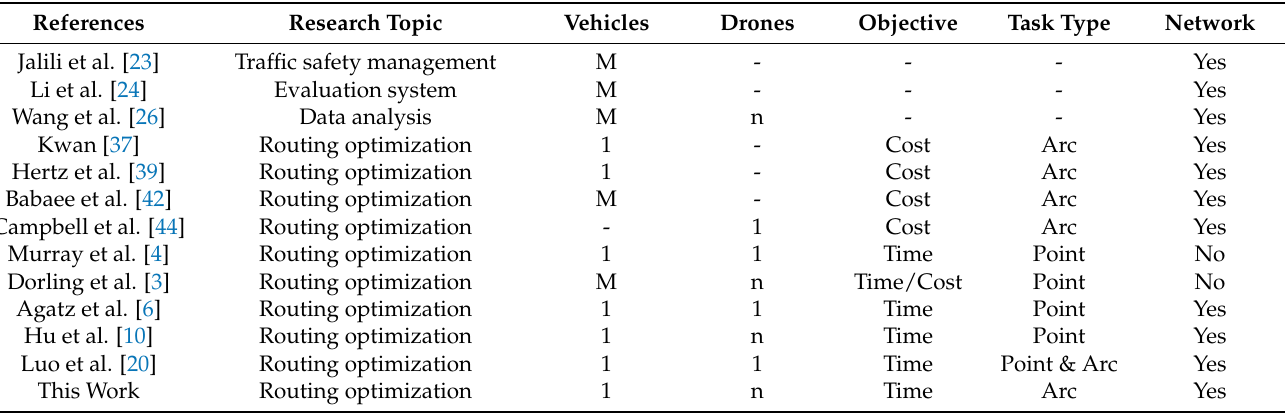
Table 1. Summary of related